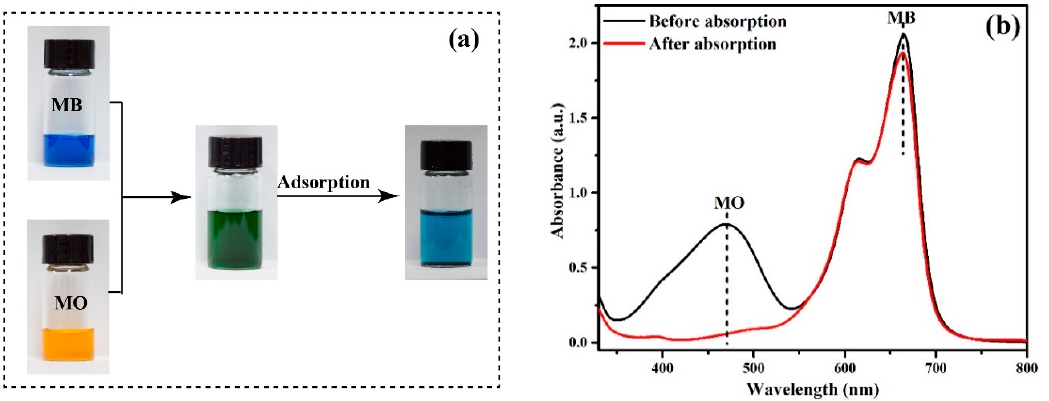
Figure 8. Photographs ( a ) and absorption spectra ( b ) of methylene blue (MB)/MO mixed solutions before and after adsorption by PANI/PSMA for 360 min. before and after adsorption by PANI / PSMA for 360